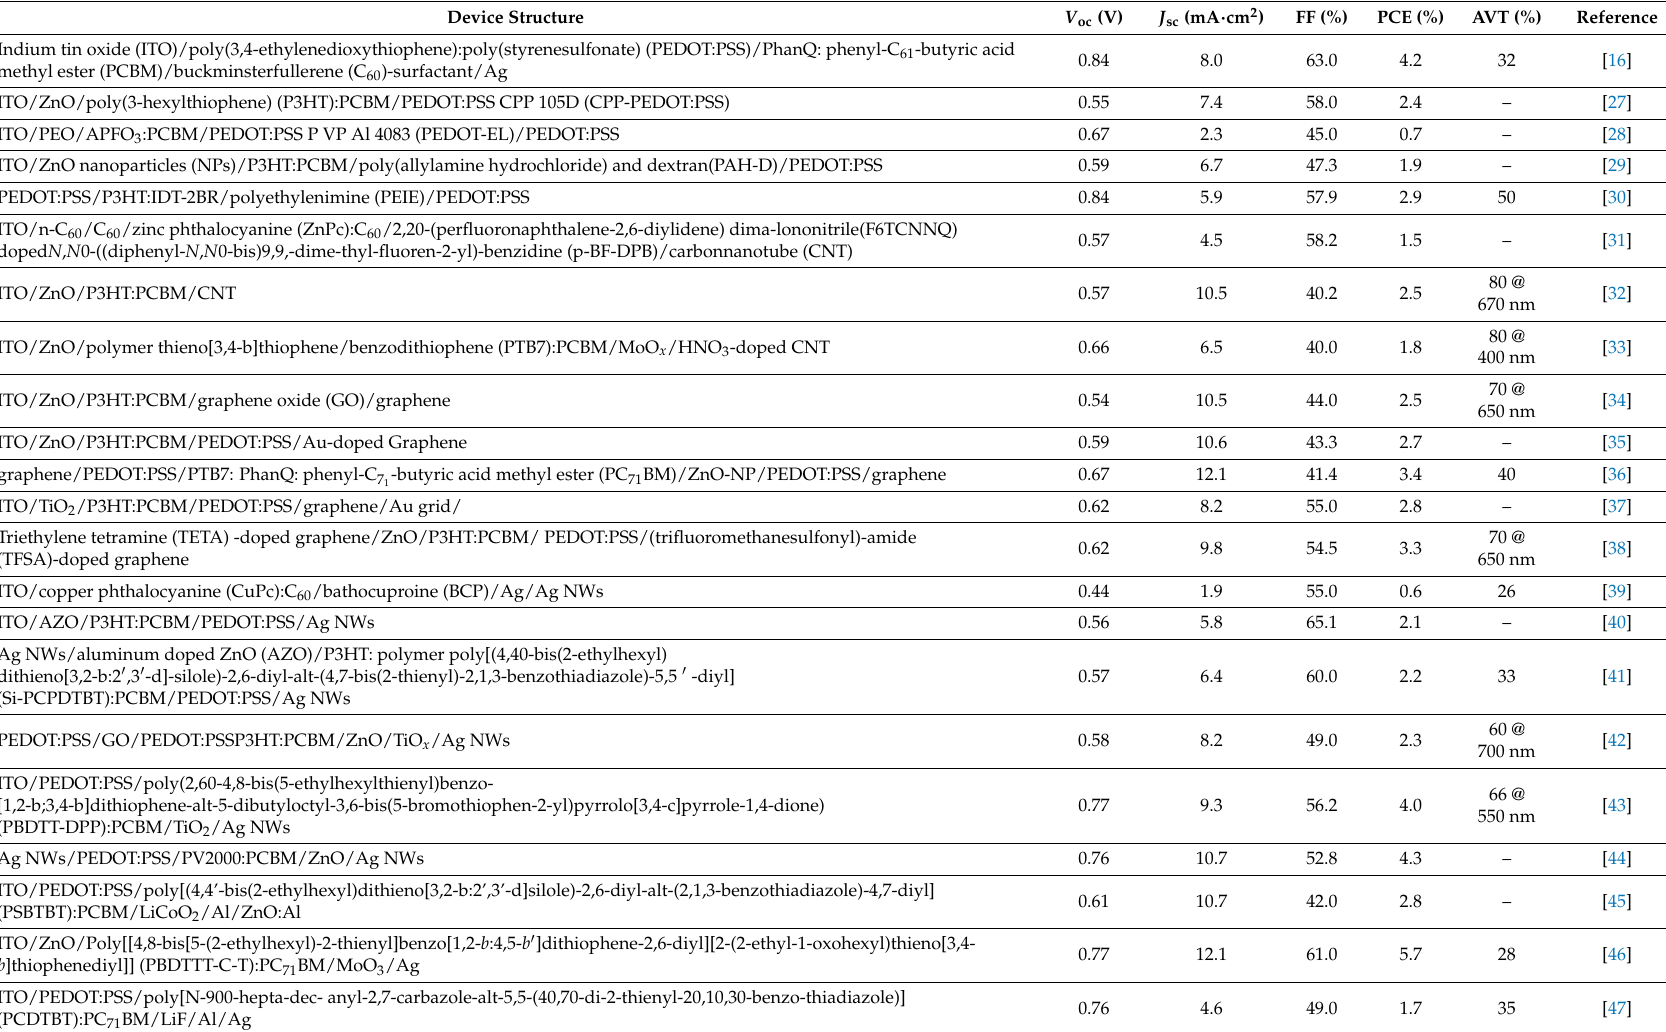
Table 2. Recently-reported photovoltaic parameters of